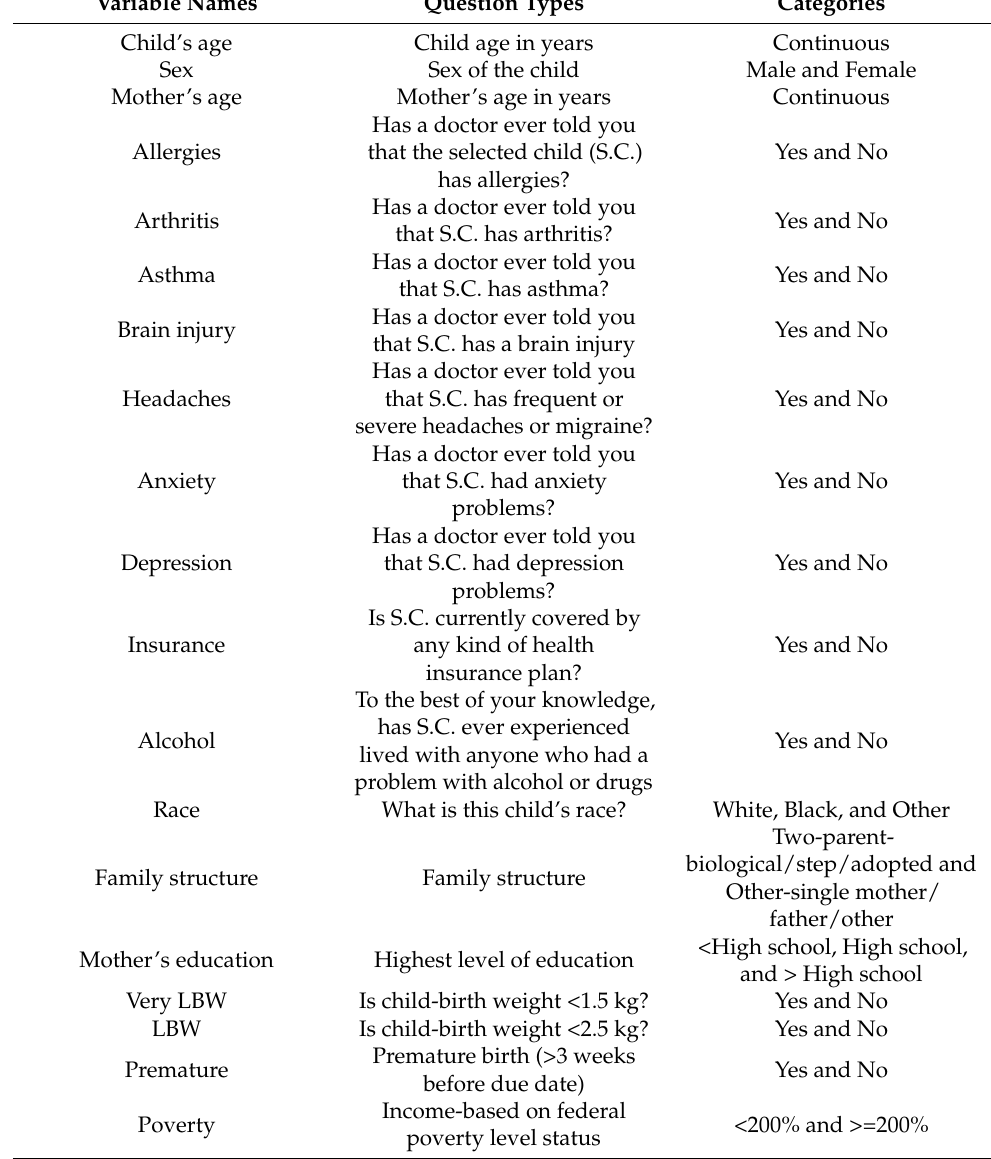
Table 1. Description of variable names, question types, and their